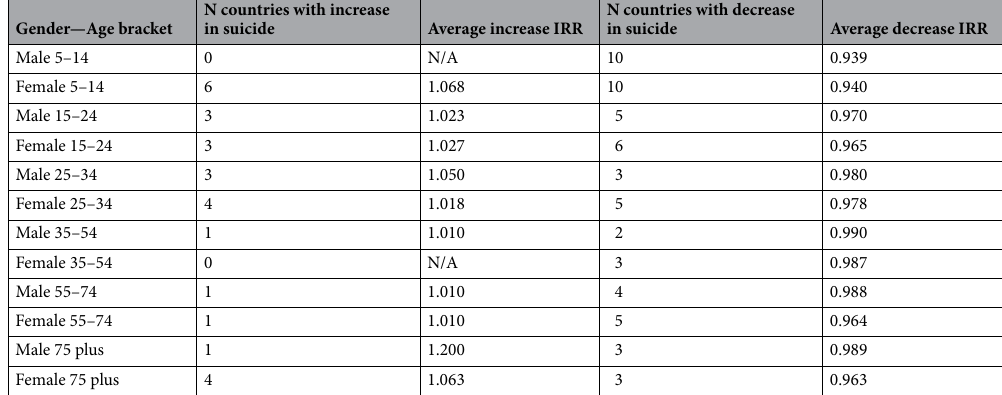
Table 2. Gender and age relevance for suicide and IRR for heatwaves.